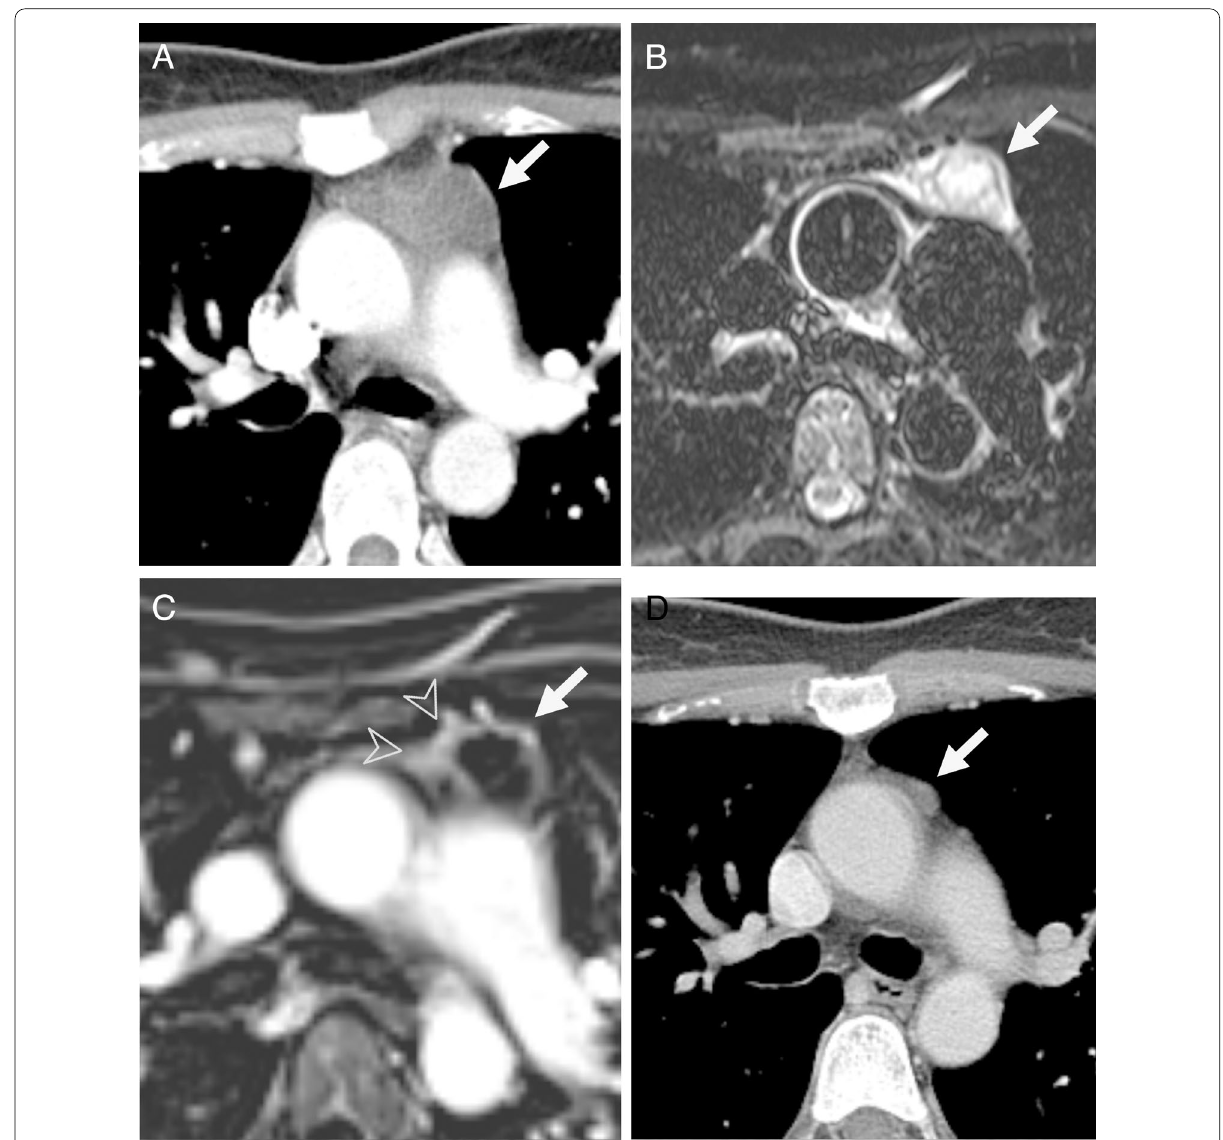
Fig. 5 Follow-up outcome of 46-year-old female with anterior mediastinal cystic lesion who underwent chest MRI. Initial contrast-enhanced chest CT shows a 46 mm anterior mediastinal mass with heterogeneous attenuation (arrow, a ). Patient underwent chest MRI after 2 weeks. On chest MRI, the lesion shows mostly high signal intensity with linear dark signal intensity septa on axial T2-weighted images (arrow, b ), suggesting multilocular cystic lesion. On subtraction images of axial post- and pre-contrast T1-weighted images, the lesion shows enhancing wall (arrow, c ) with irregular and eccentric wall thickening (arrowhead, c ). The lesion can be classified as an indeterminate lesion (complex cyst) based on chest MRI findings and the differential diagnosis of MRI reading included complicated thymic cyst and cystic thymoma. Patient underwent 3-month follow-up after the MRI rather than immediate surgery. On 3-month follow-up CT, the lesion shows a marked decrease in size of anterior mediastinal lesion (arrow, d ), which suggests the benign nature of lesion, complicated thymic